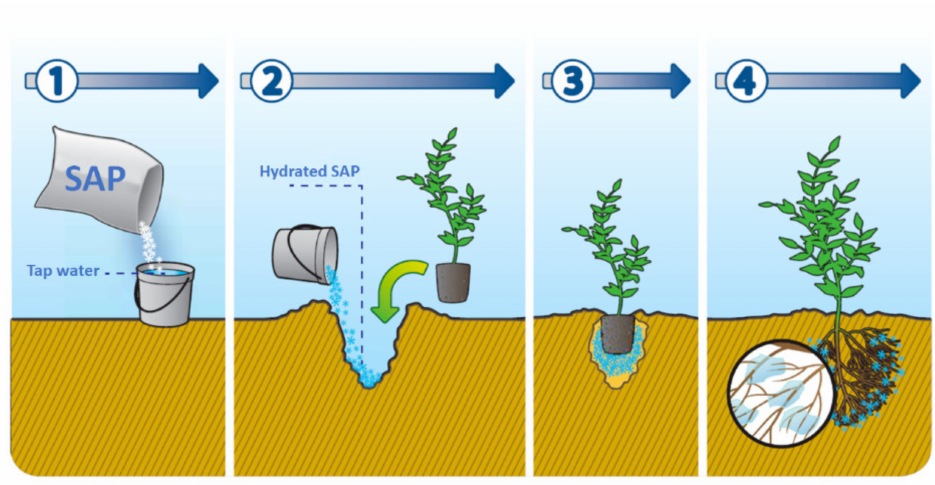
Figure 2. Use of SAP in